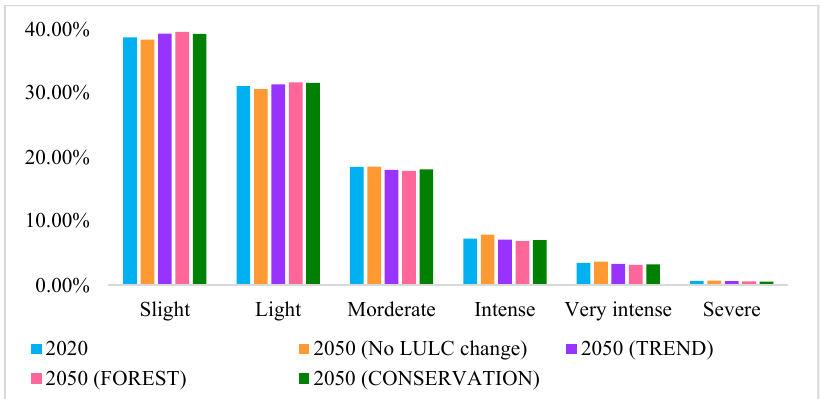
Figure 7. Percentage of soil erosion level under different scenarios (2050) and for 2020. (2). Water yield.